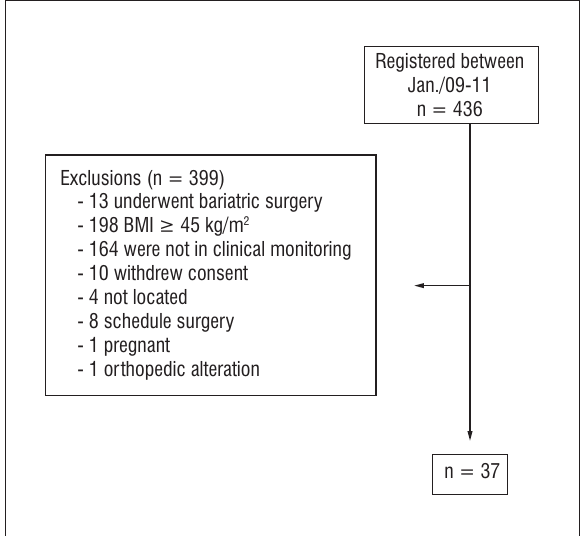
Figure 1 - Flow chart of